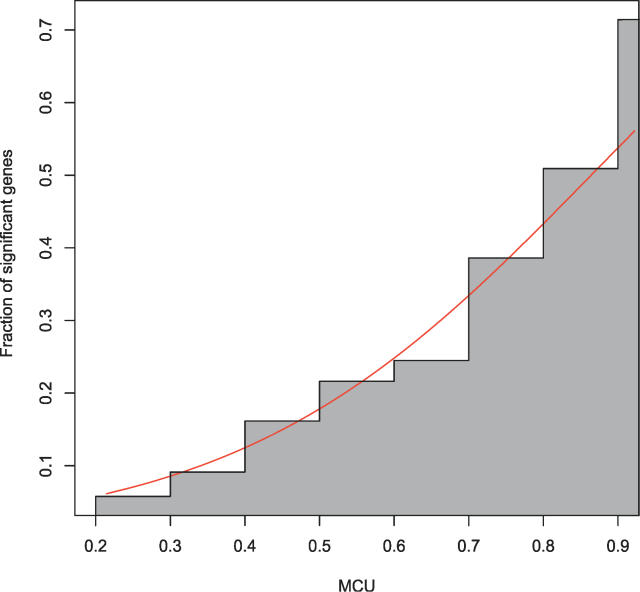
Fraction of Significant Genes Predicted from MCU by Logistic RegressionLogistic regression (p < 2.2 × 10−16) linking the fraction of genes significantly robust (i.e., being significantly less mutable than expected according to protein sequence) to gene MCU (used here as a proxy for gene expression). The red line represents the fraction of significant genes predicted by the regression, and the grey histogram represents the observed fraction of significant genes by class of gene MCU.